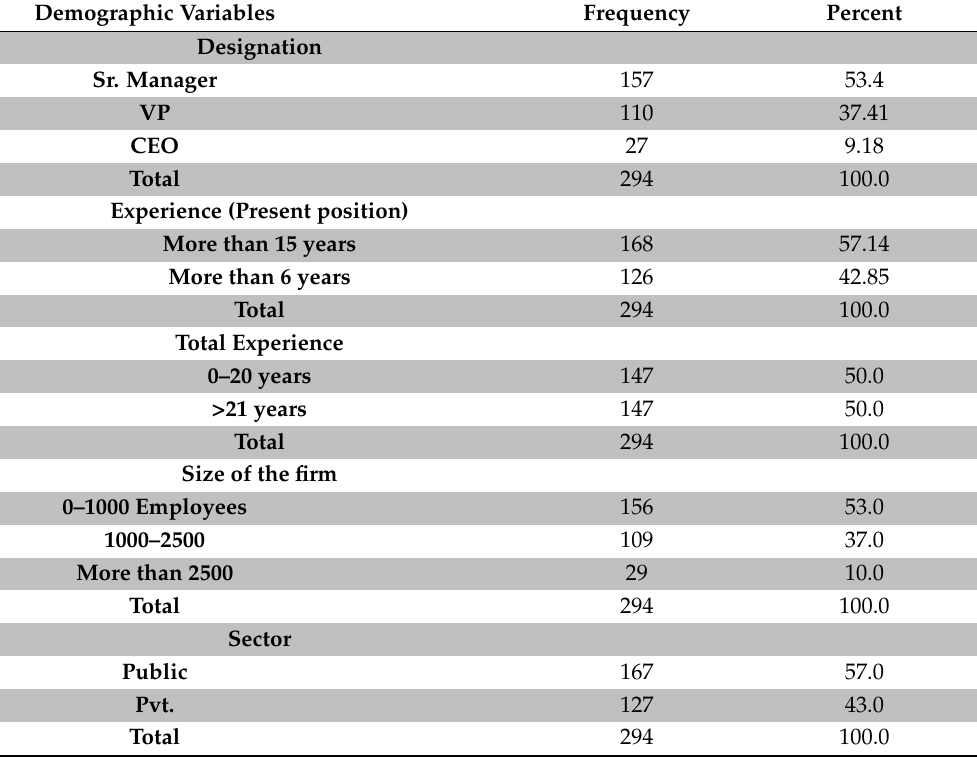
Table 3. Descriptive